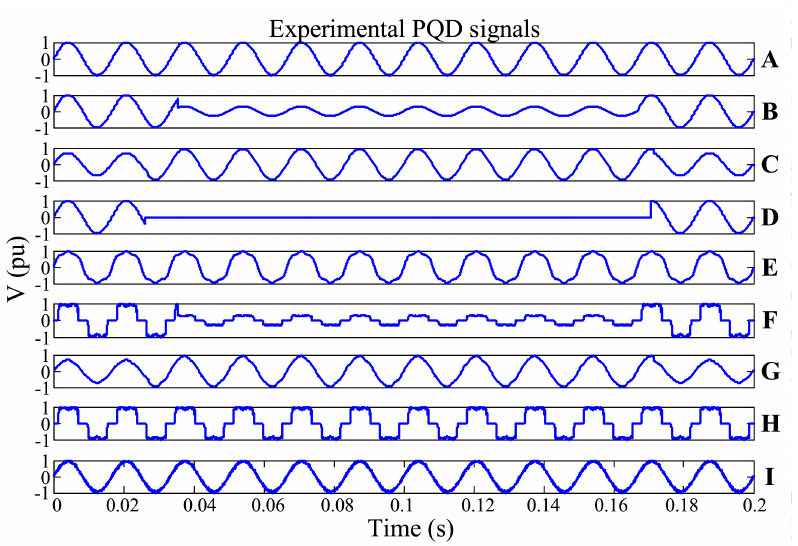
Figure 6. Acquired signal from the experimental setup with